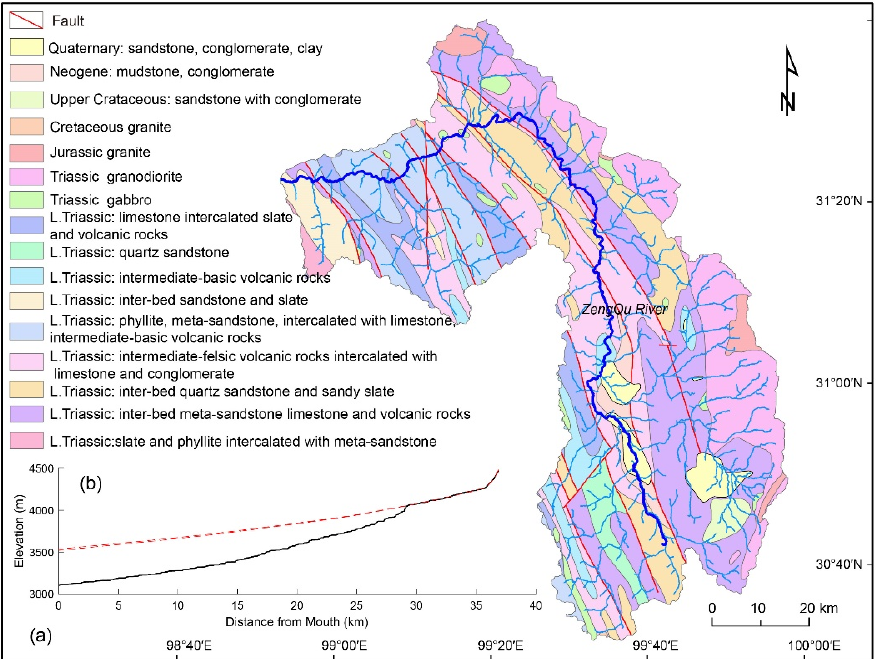
Figure 2. Simplified geological map (after 1:500,000 Chinese geological map) ( a , b ) reconstructed river long profile of the trunk stream of the Zengqu river extracted from the 30-m-resolution SRTM-DEM (derived from https://earthexplorer.usgs.gov/, accessed on 20 October 2020) (red dotted line is paleo-river profile and black line is modern river profile).